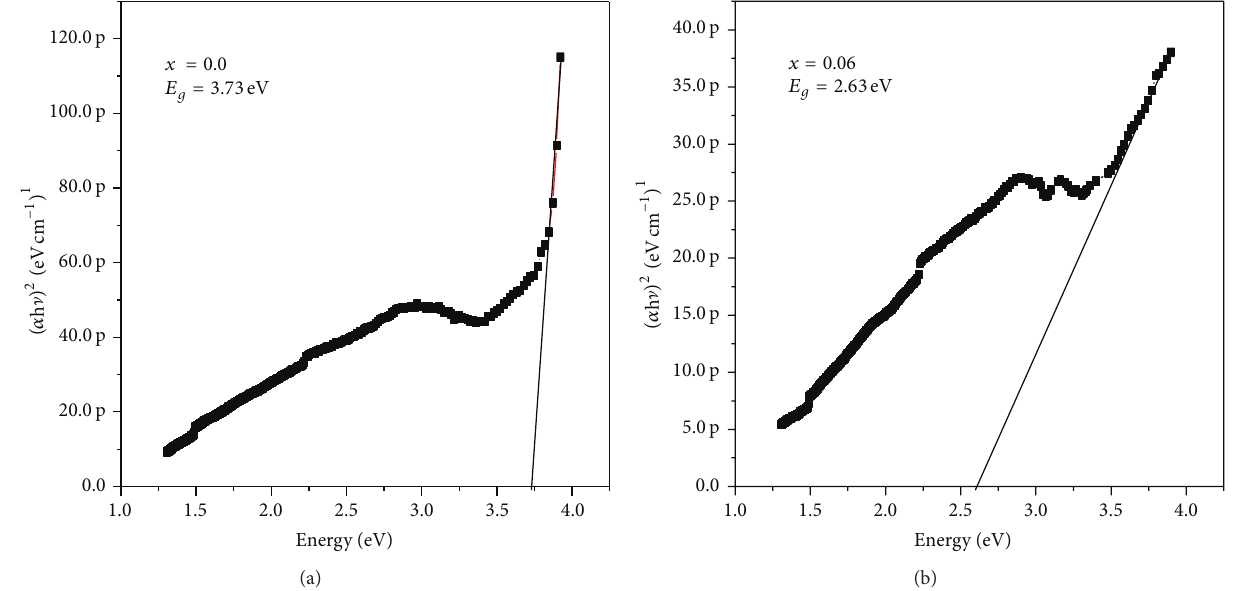
Figure 4: Plot of (𝛼ℎ ] ) 2 versus energy of (a) Zn 0.9 Co 0.1 Cd 0.0 O and (b) Zn 0.9 Co 0.04 Cd 0.06 O.